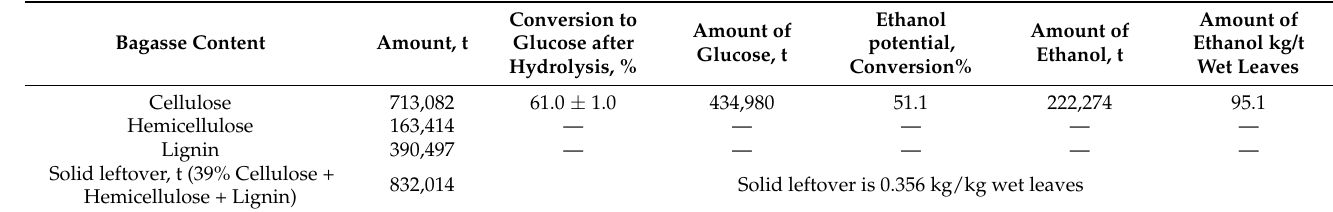
Table 14. Potential of ethanol production from